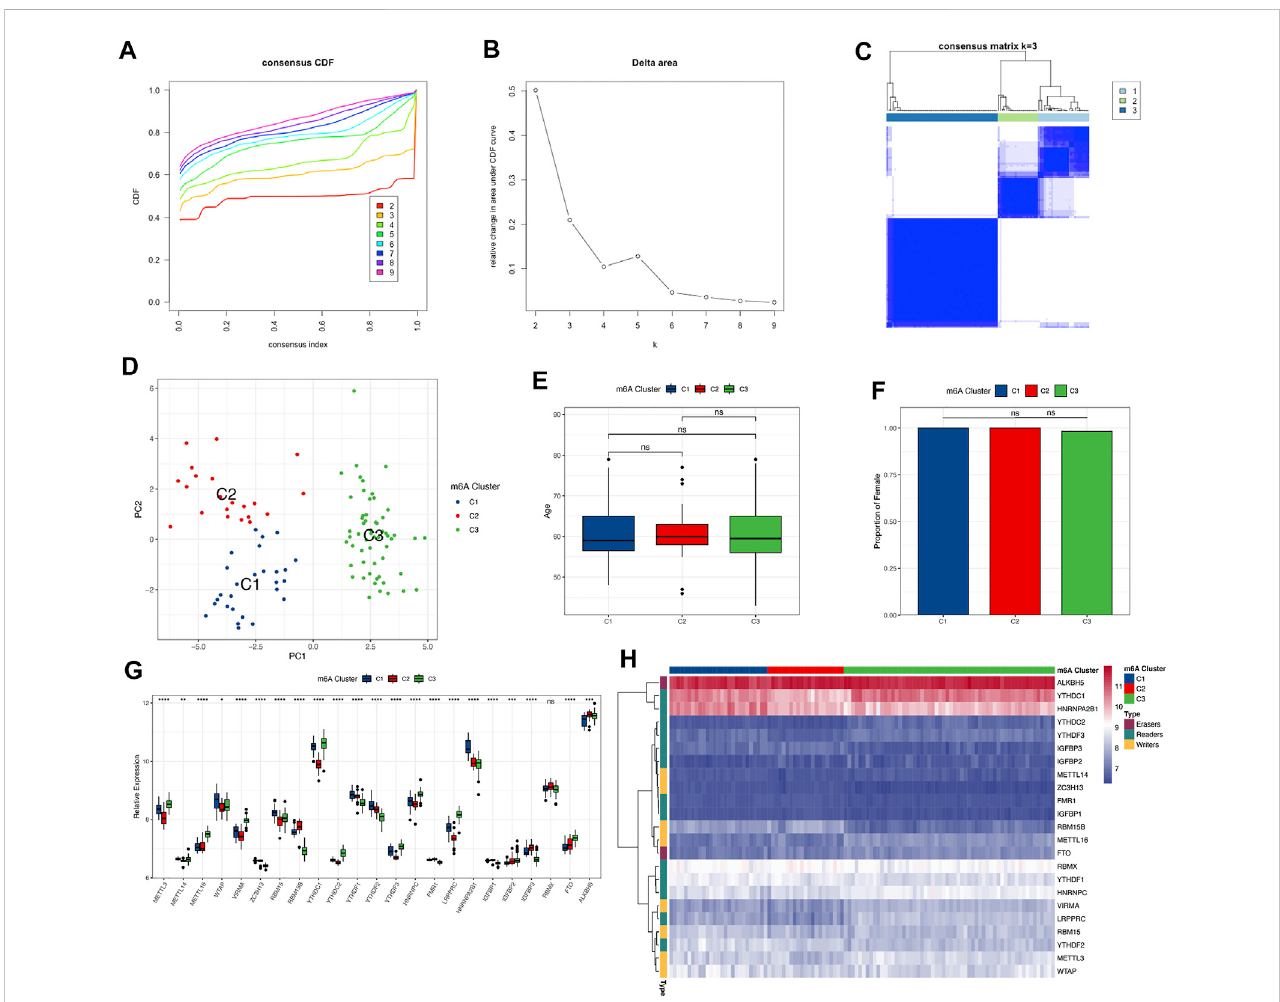
FIGURE 4 Identi fi cation of subtypes by unsupervised clustering based on the expression of 23 m 6 A regulators. (A) Consensus clustering cumulative distribution function(CDF)fork=2 – 9. (B) RelativechangeintheareaundertheCDFcurvefork=2 – 9. (C) Heatmapoftheconsensusmatrixforosteoarthritissamples. (D) PCA of the transcriptome pro fi les of 3 m 6 A subtypes, showing a remarkable difference in the transcriptome between different modi fi cation patterns. (E,F) Comparison of age and gender. The boxplot illustrated the association of age with the 3 subtypes. The bar plot illustrates the association of age with the 3subtypes.Abovensmeansthedifferencewasnotstatisticallysigni fi cant. (G) Expressiondifferencesof23m 6 Aregulatorsamongthe3m 6 Asubtypes.Above* indicates p < 0.05, ** indicates p < 0.01, *** indicates p < 0.001, **** indicates p < 0.0001, and ns indicates that the difference was not statistically signi fi cant. (H) Heatmap of the expression status of 23 m 6 A regulators in the 3 subtypes with unsupervised